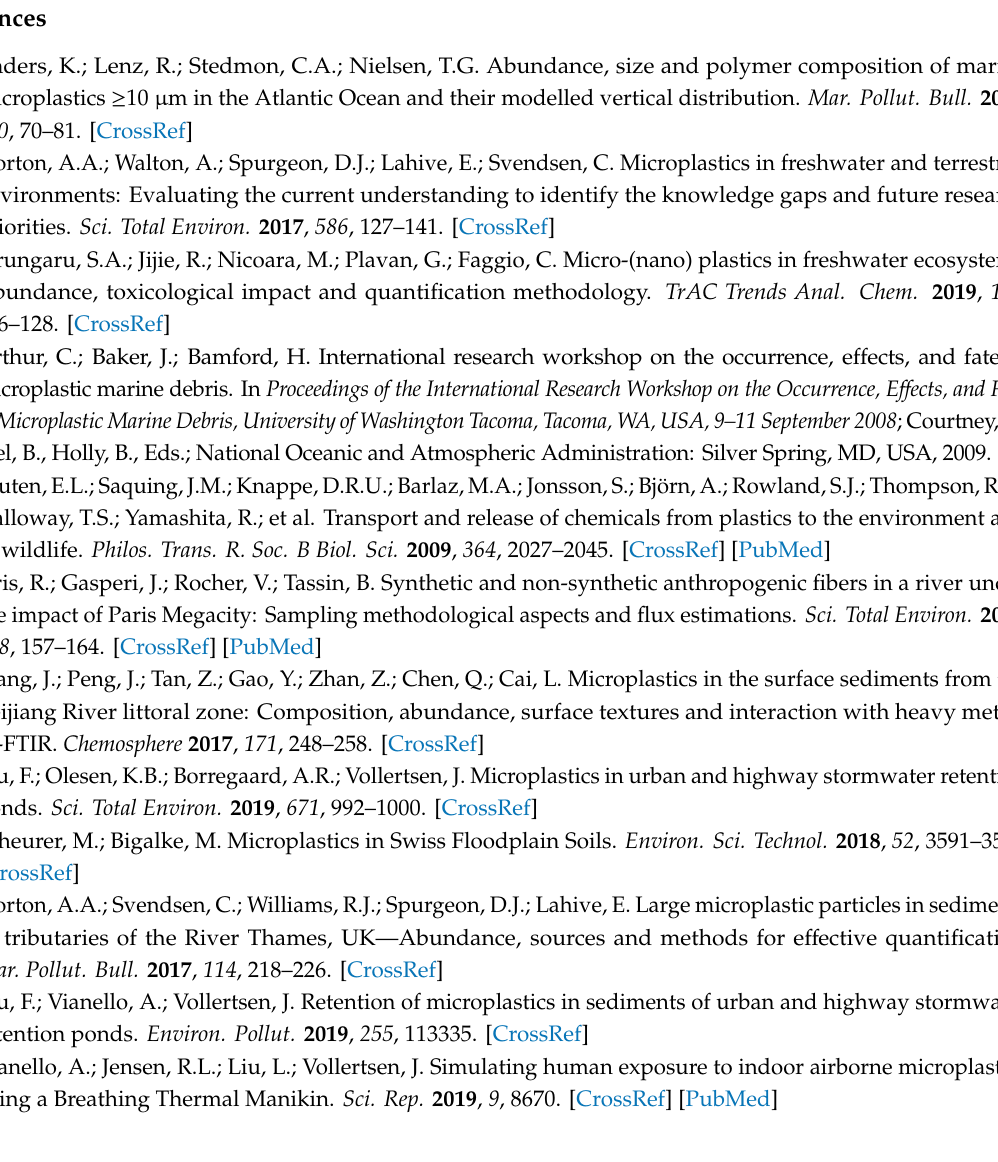
Figure S1: Biofilm growth (photo taken from the top of the filter before the sampling); Table S1: MP concentration and removal e ffi ciency for the inlet (raw e ffl uent without passing through the biofilter and each filtration level); Table S2: MP concentration and removal e ffi ciency when the four treatment levels are